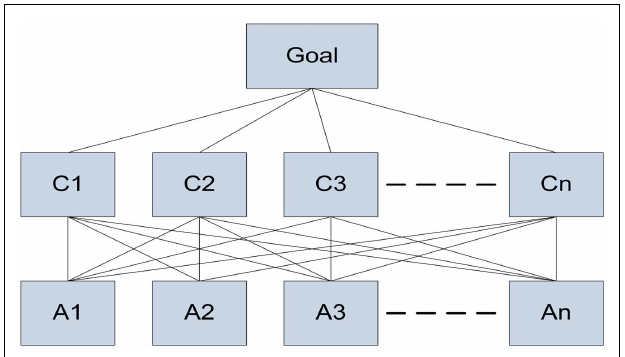
FIGURE 1 | Basic steps inAHP technique .